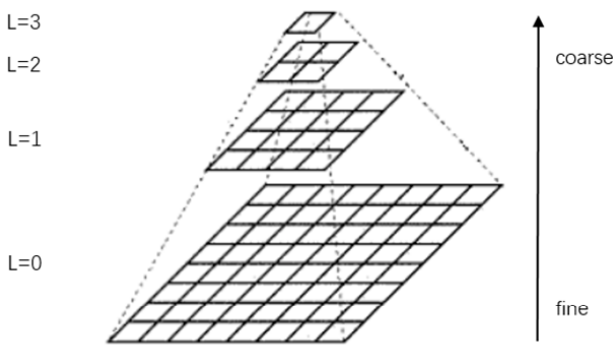
Figure 13. The structure of the image pyramid. L stands for the image layer, from the original (L = 0) to coarser ones by continuously down-sampling. to coarser ones by continuously